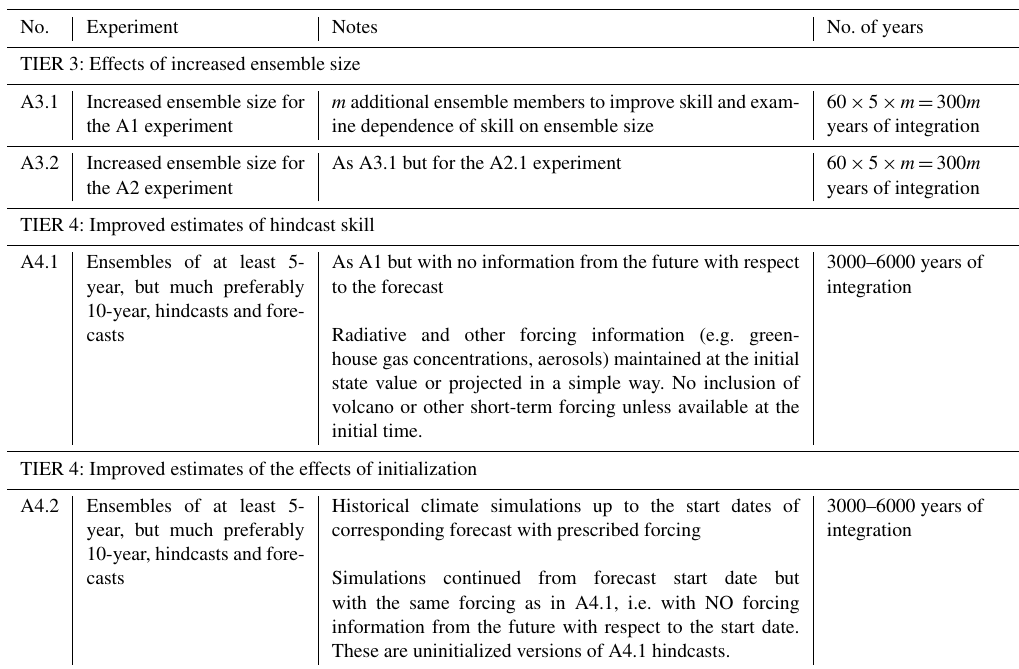
Table A2. Other hindcast experiments (if resources permit). No. Notes No. of